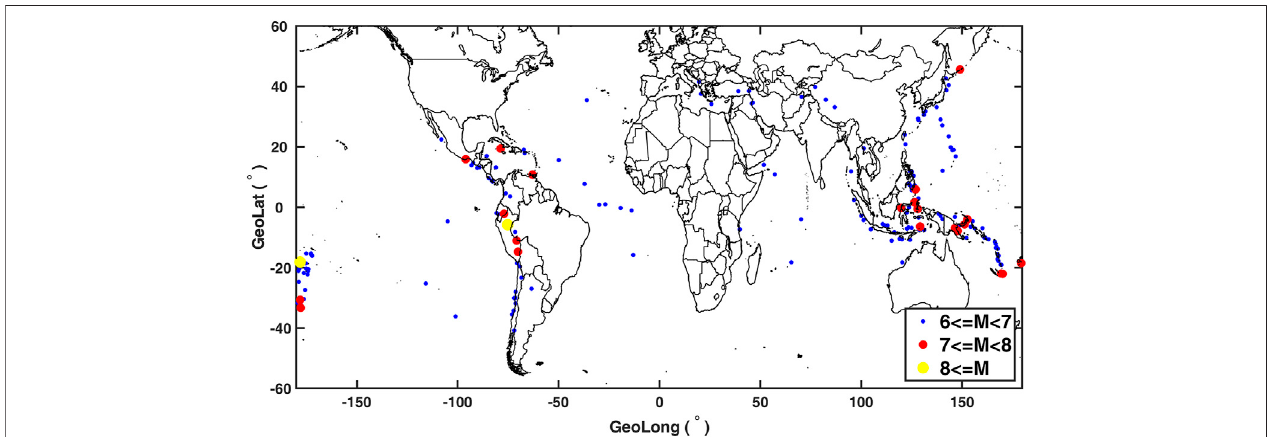
FIGURE7| Epicenterslocationsofglobal Mw ≥ 6.0earthquakes from1June2018to30September 2020.Bluepointsrepresenttheearthquakes withmagnitude greater than 6 but less than 7. Red points represent the earthquakes with magnitude greater than 7 but less than 8. Yellow points represent the earthquakes with magnitude greater than 8.